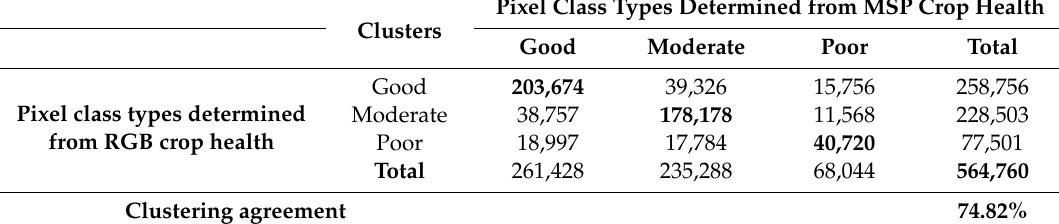
Table 5. Cross-tabulation table of the computed MSP and RGB crop health maps comparing the clustering accuracy of all of the pixels within the study area into good, moderate, and poor